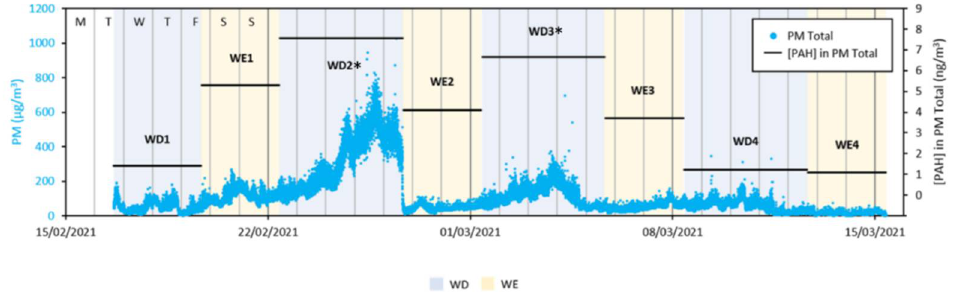
Figure 7. Temporal distribution of PM Total and total PAH concentration in PM Total. (* used to indicate the sampling periods when the pollution episodes occurred.)